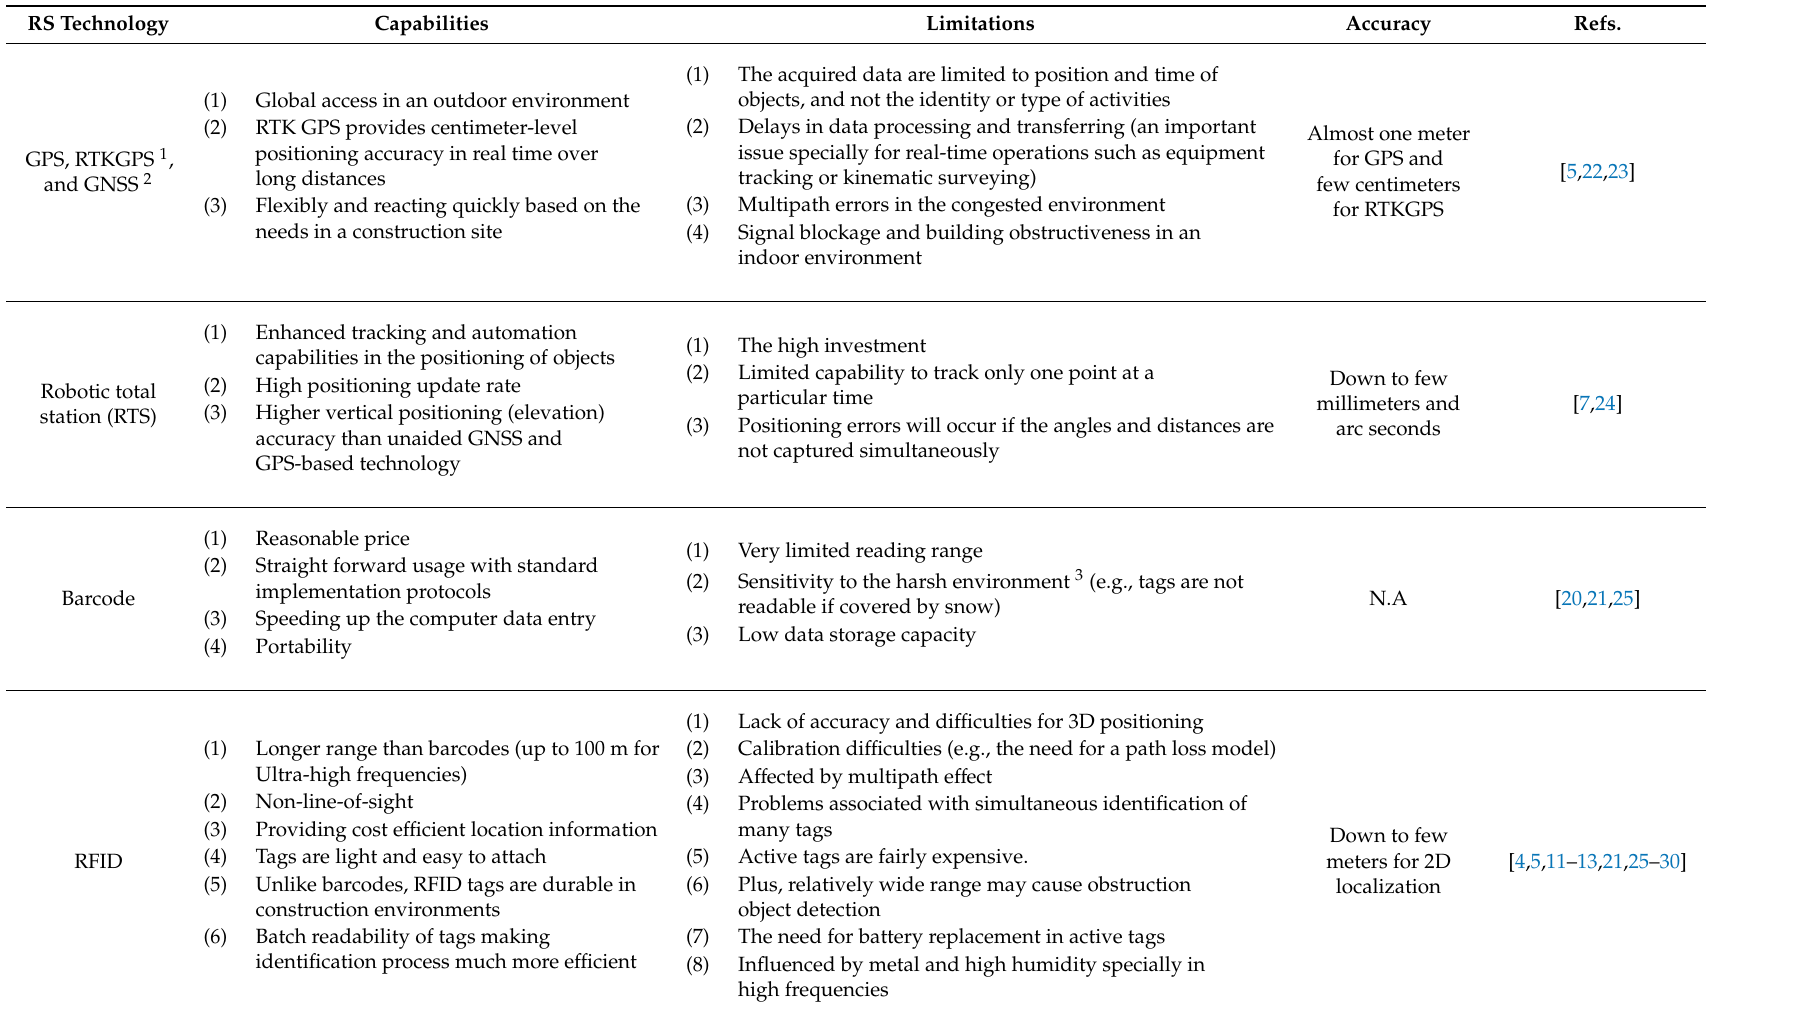
Table 2. Capabilities and limitations of standalone remote sensing (RS) technologies Limitations Accuracy